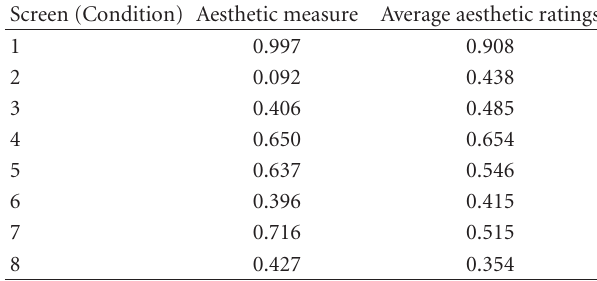
Table 2: Calculated aesthetic values and participants’ average aesthetic ratings.